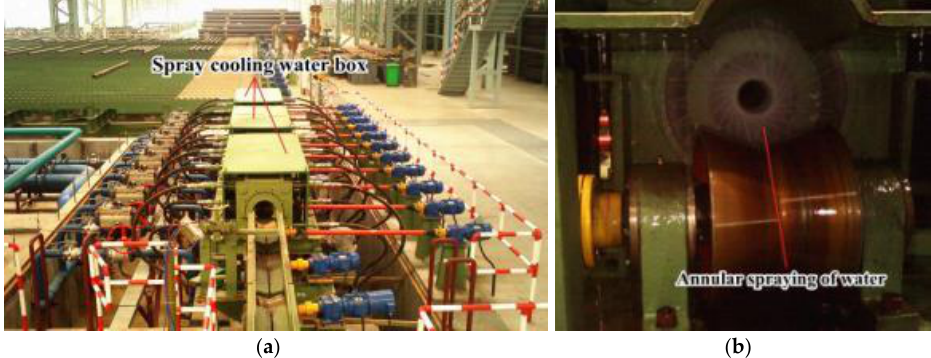
Figure 3. Arrangement of water boxes and its operating state ( a ) arrangement of spray water boxes; ( b ) operating state of spraying water.